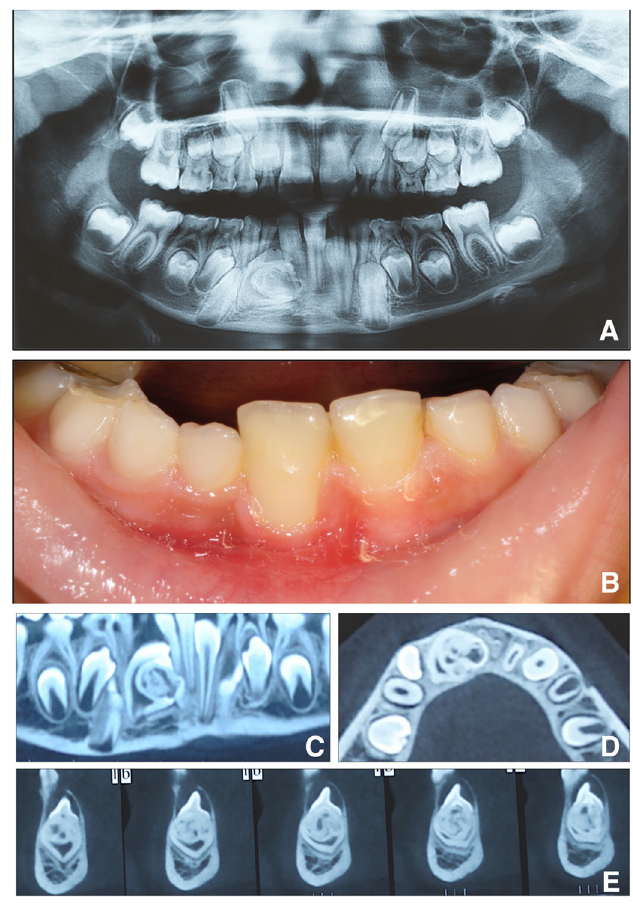
Fig. 2. (A) Panoramic X-ray fi ndings at the fi rst visit. (B) Intraoral clinical photograph at the fi rst visit. (C) CBCT Panoramic view. (D) CBCT Axial view. (E) CBCT Coronal view. CBCT fi ndings showing a well circumscribed shell shaped with a complex hypodense/ hyperdense anatomy.